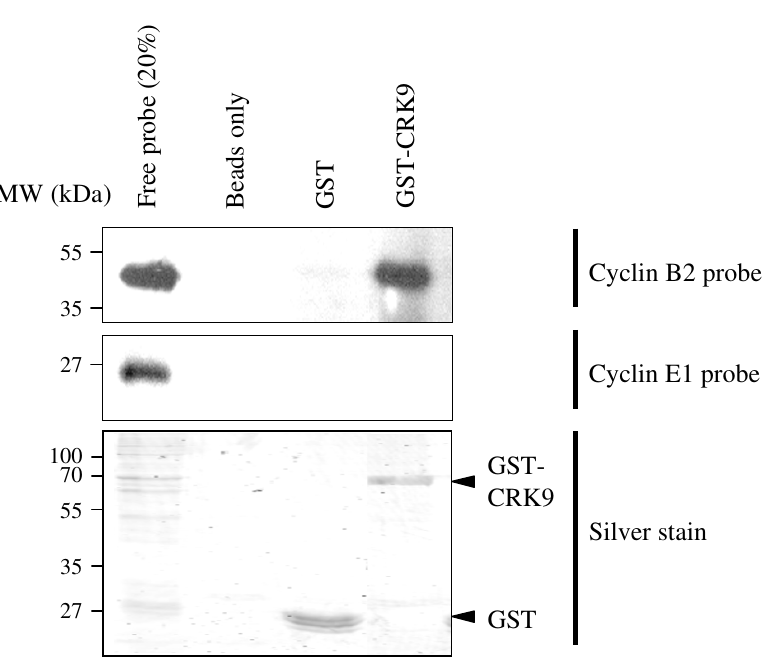
Figure 4 CRK9 interacts with cyclin B2 . Recombinant GST-CRK9 was purified from transformed E. coli and incubated with the in vitro transcribed/translated HA-tagged cyclins E1 and B2, respectively. The GST protein complexes were bound to glutathione agarose, washed extensively, and analyzed by SDS PAGE followed by anti-HA Western blotting (top and central panels, as